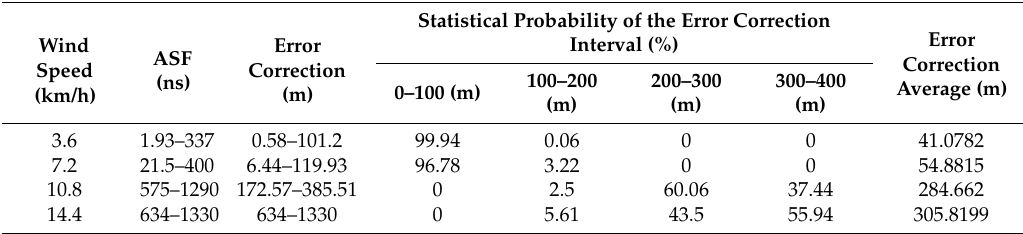
Table 2. The corresponding data change table of Figure 13.